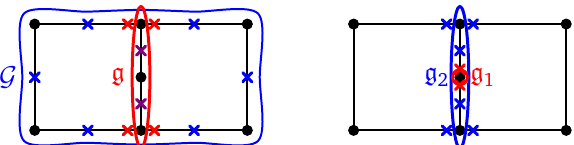
Figure 3: Examples of two facets related to subgraphs which do not correspond to partially overlapping channels but still their intersection lies outside of the cosmo- logical polytope. They correspond to double cuts other than the ones which provide the Steinmann